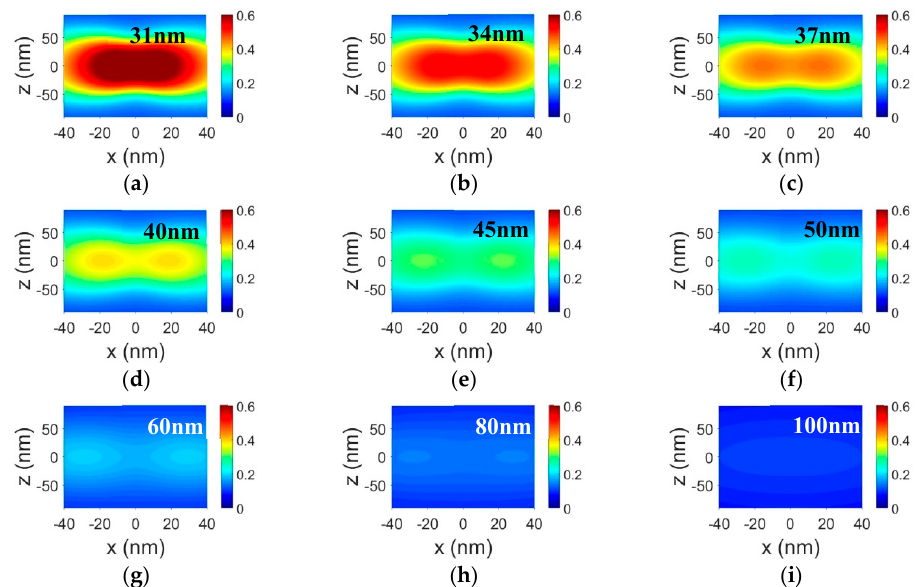
Figure 6. The electric field distributions of the silver nanorod with a diameter of 30 nm and a length of 100 nm for the TM polarization (along the x-direction). ( a – i ) The electric field profiles of E(x, z) at 517 nm in different near field regions when adding the 2D y-normal monitor in the positions of y = 31, 34, 37, 40, 45, 50, 60, 80, and 100 nm, respectively.